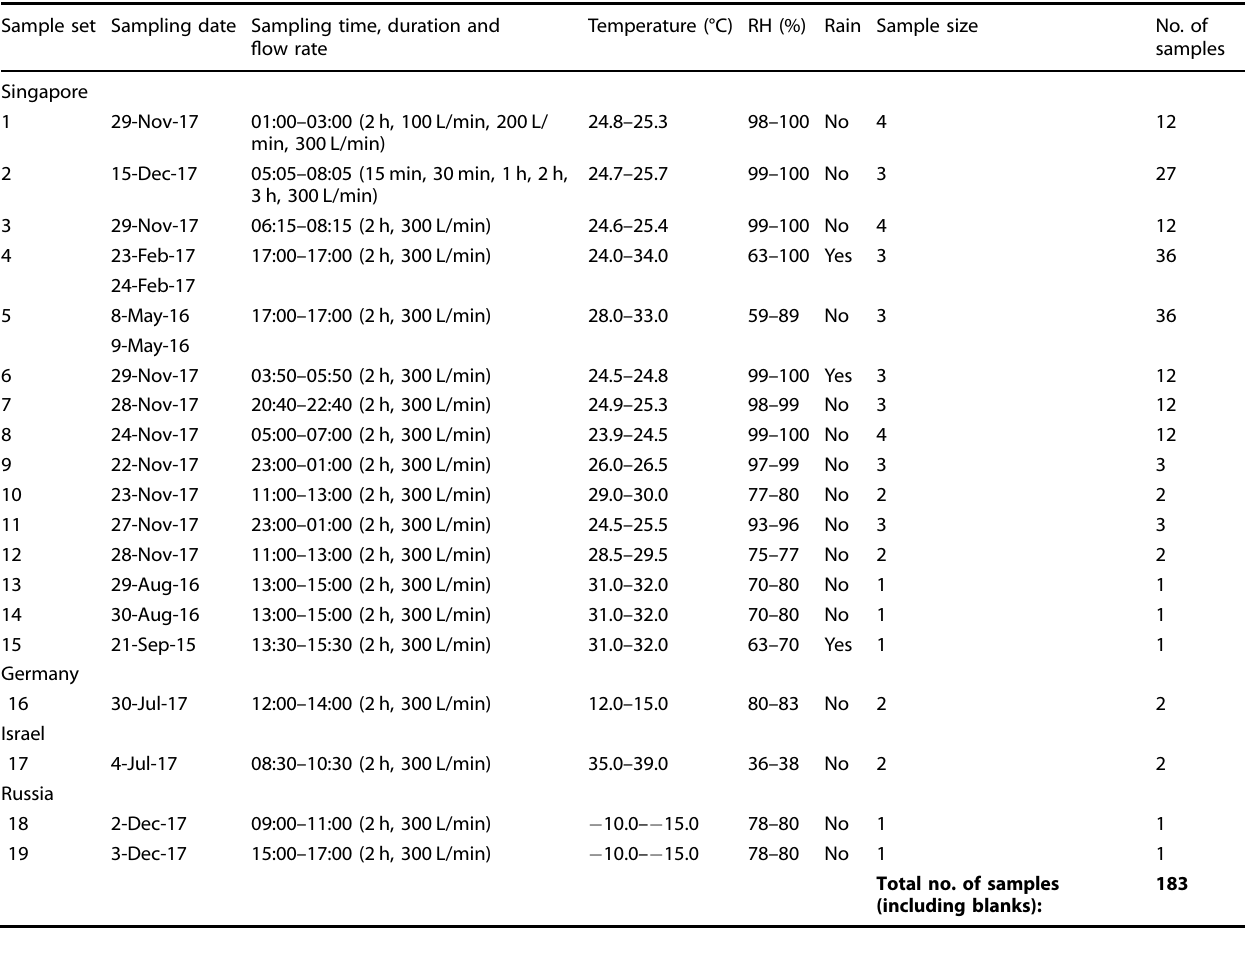
Table 1. Details of sampling